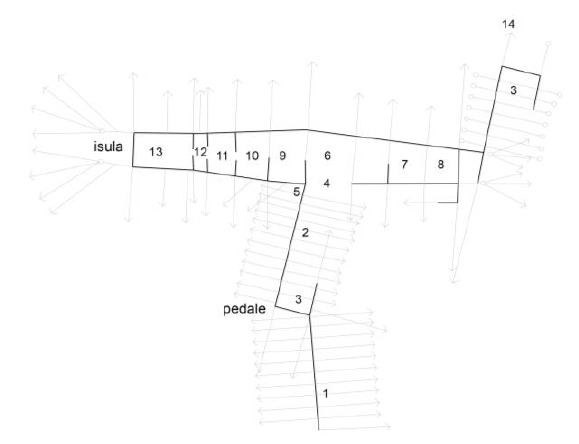
Figure 2. Diagram of the madraga: 1. toccu mediu - 2. toccu avutu - 3. campile - 4. vucca foraticu - 5. spicu - 6. foraticu - 7. ranni - 8. cammara ri livanti – 9. urdunaru – 10. bastardu – 11. cammara ri tunni or ponenti – 12. bastardedda – 13. corpu – 14. ancora di